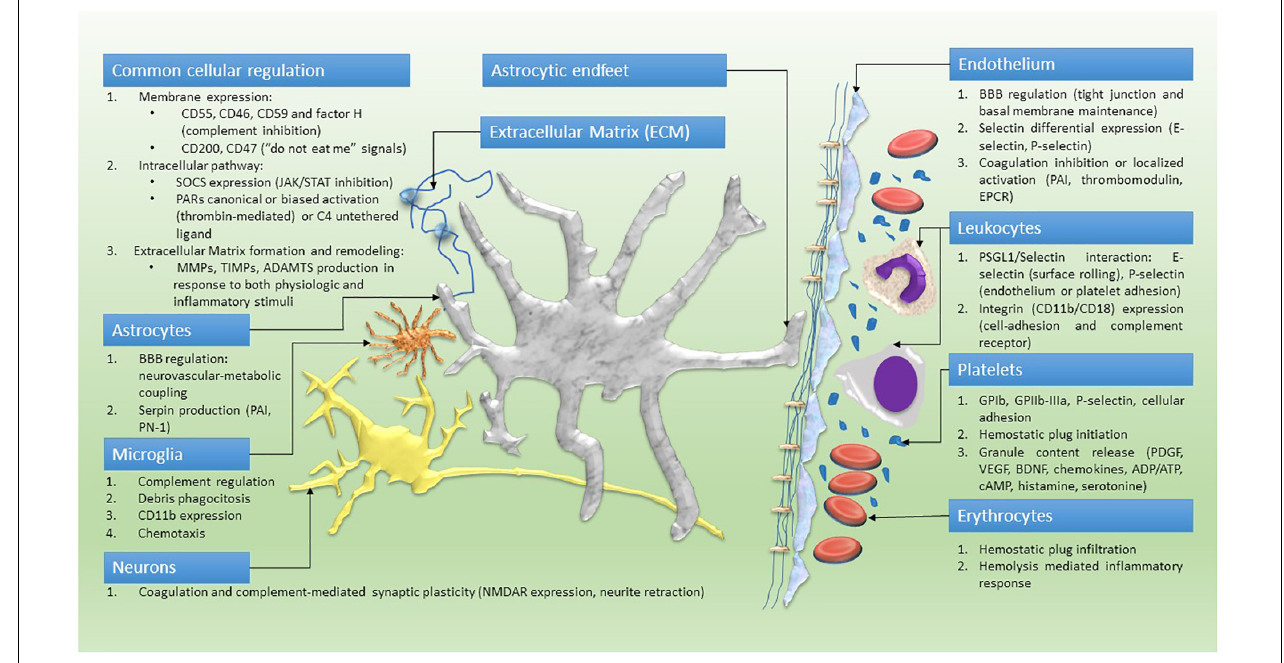
FIGURE 2 | Cellular model of a pentapartite synapse. Common cellular pathways and cell-specific role within the neuro-immune hemostasis